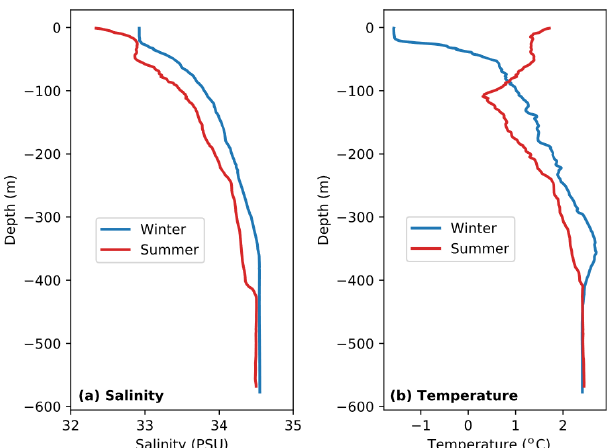
Figure 2. Ambient fjord salinity and temperature profiles used as input to the plume model (Chauché, 2016). Winter conditions from CTD cast on 2 March 2013 approximately 10km from the calving front; summer conditions from CTD cast on 2 August 2012 approx- imately 1km from the calving front. (a) Salinity in winter and sum- mer; (b) temperature in winter and